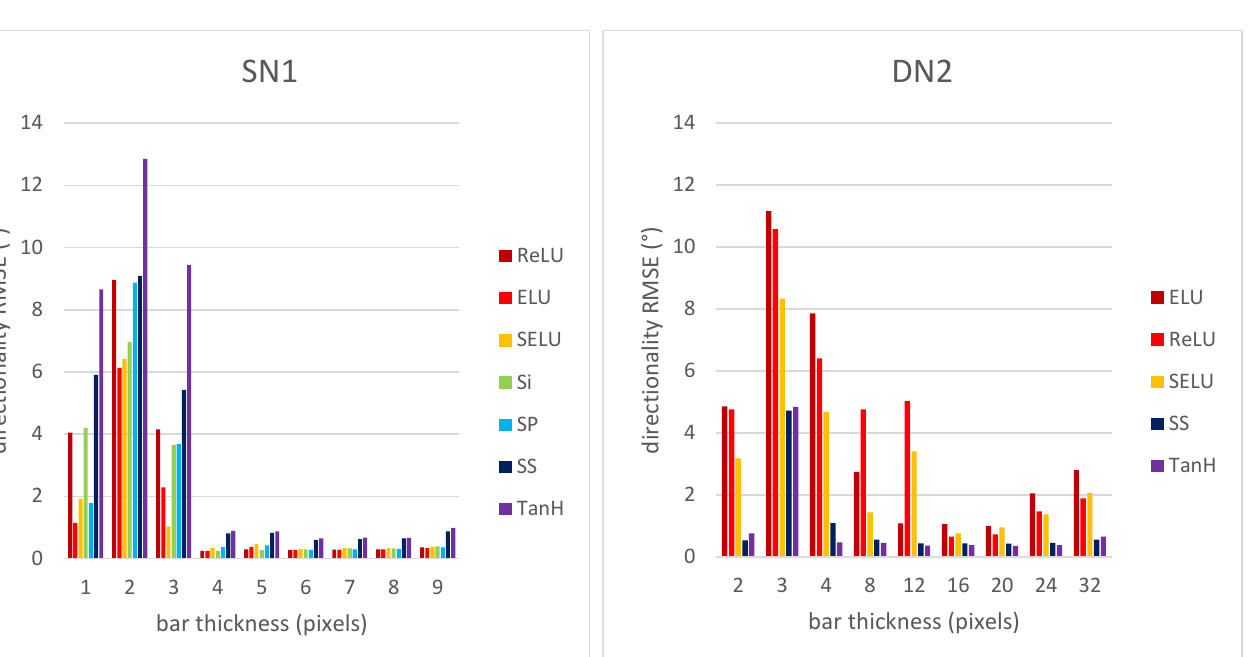
Figure 7. Directionality RMSE for CNNs SN1 and DN2 vs. blur kernel size. Both shallow and deep CNNs are sensitive to blurring for kernel size 7 × 7 and be- yond. As before, the best performing activation functions for the shallow CNN are ELU and SELU, whereas for the deep CNN are TanH and SS. Finally, in Figure 8 the directionality RMSE vs. Gaussian noise standard deviation for CNNs SN1 and DN2 is shown.